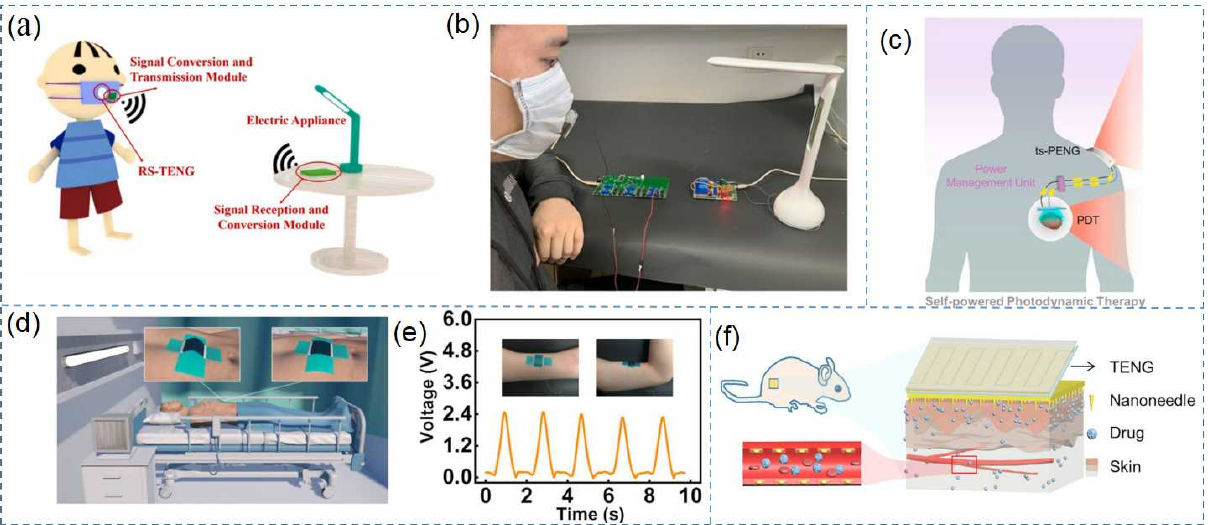
Figure 12. Use of TENG in future medical applications. ( a , b ) TENG-based respiratory monitoring face mask. Reprinted with permission from ref. [132]. Copyright 2022 Nano Energy; ( c ) TENG-based cancer treatment device. Reprinted with permission from ref. [133]. Copyright 2022 Nano Energy; ( d ) TENG-based bandage sensor; ( e ) bandage sensor attached to the arm to measure the voltage signal. Reprinted with permission from ref. [134]. Copyright 2022 Nano Energy; ( f ) schematic diagram of drug delivery based on TENG.